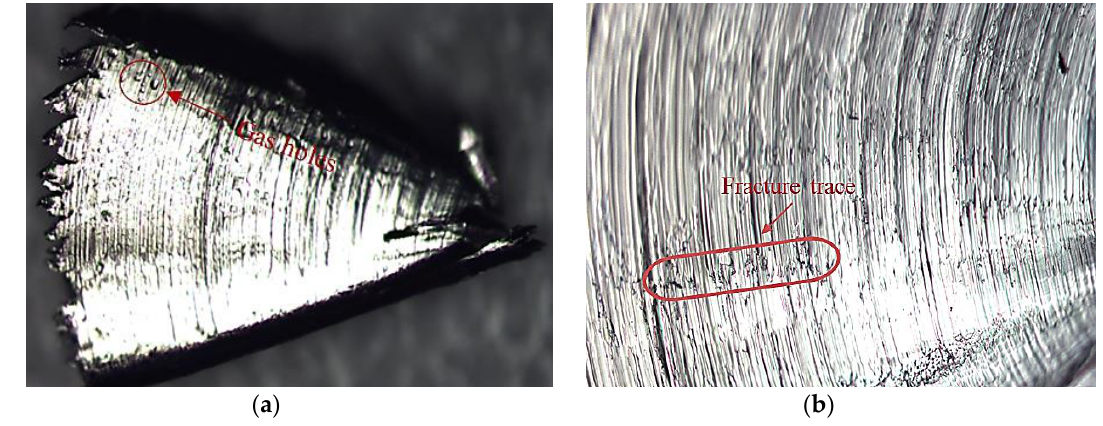
Figure 16. Defects on the chip morphology ( a ) air/gas pores on the chip surface and ( b ) fracture trace.